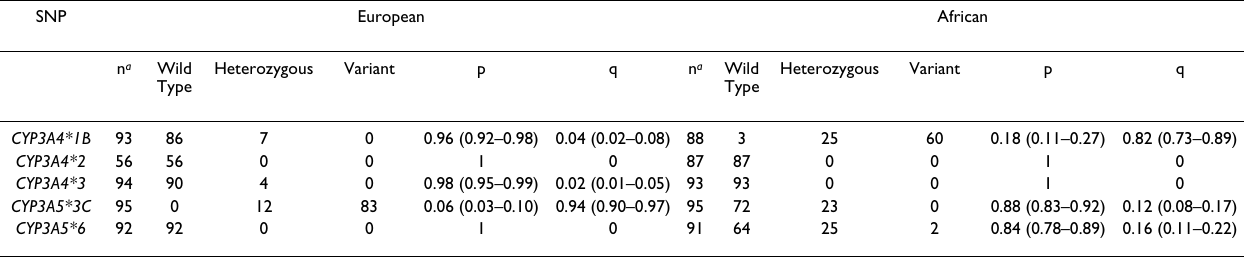
Table 2: Genotype and allele frequencies for CYP3A4 and CYP3A5 SNPs in European and African populations. Figures in brackets are 95% confidence intervals. SNP